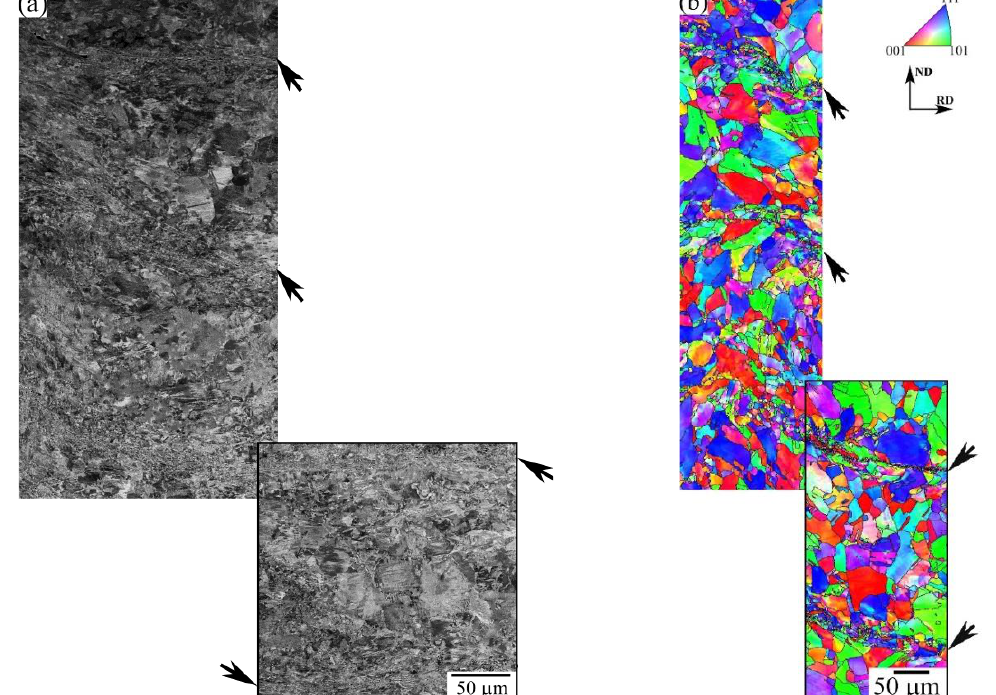
Figure 5. Microstructure of the consolidated sample: ( a ) backscattered electron images; ( b ) crystal orientation map with color code in right top corner; the joint zones are indicated with arrows.